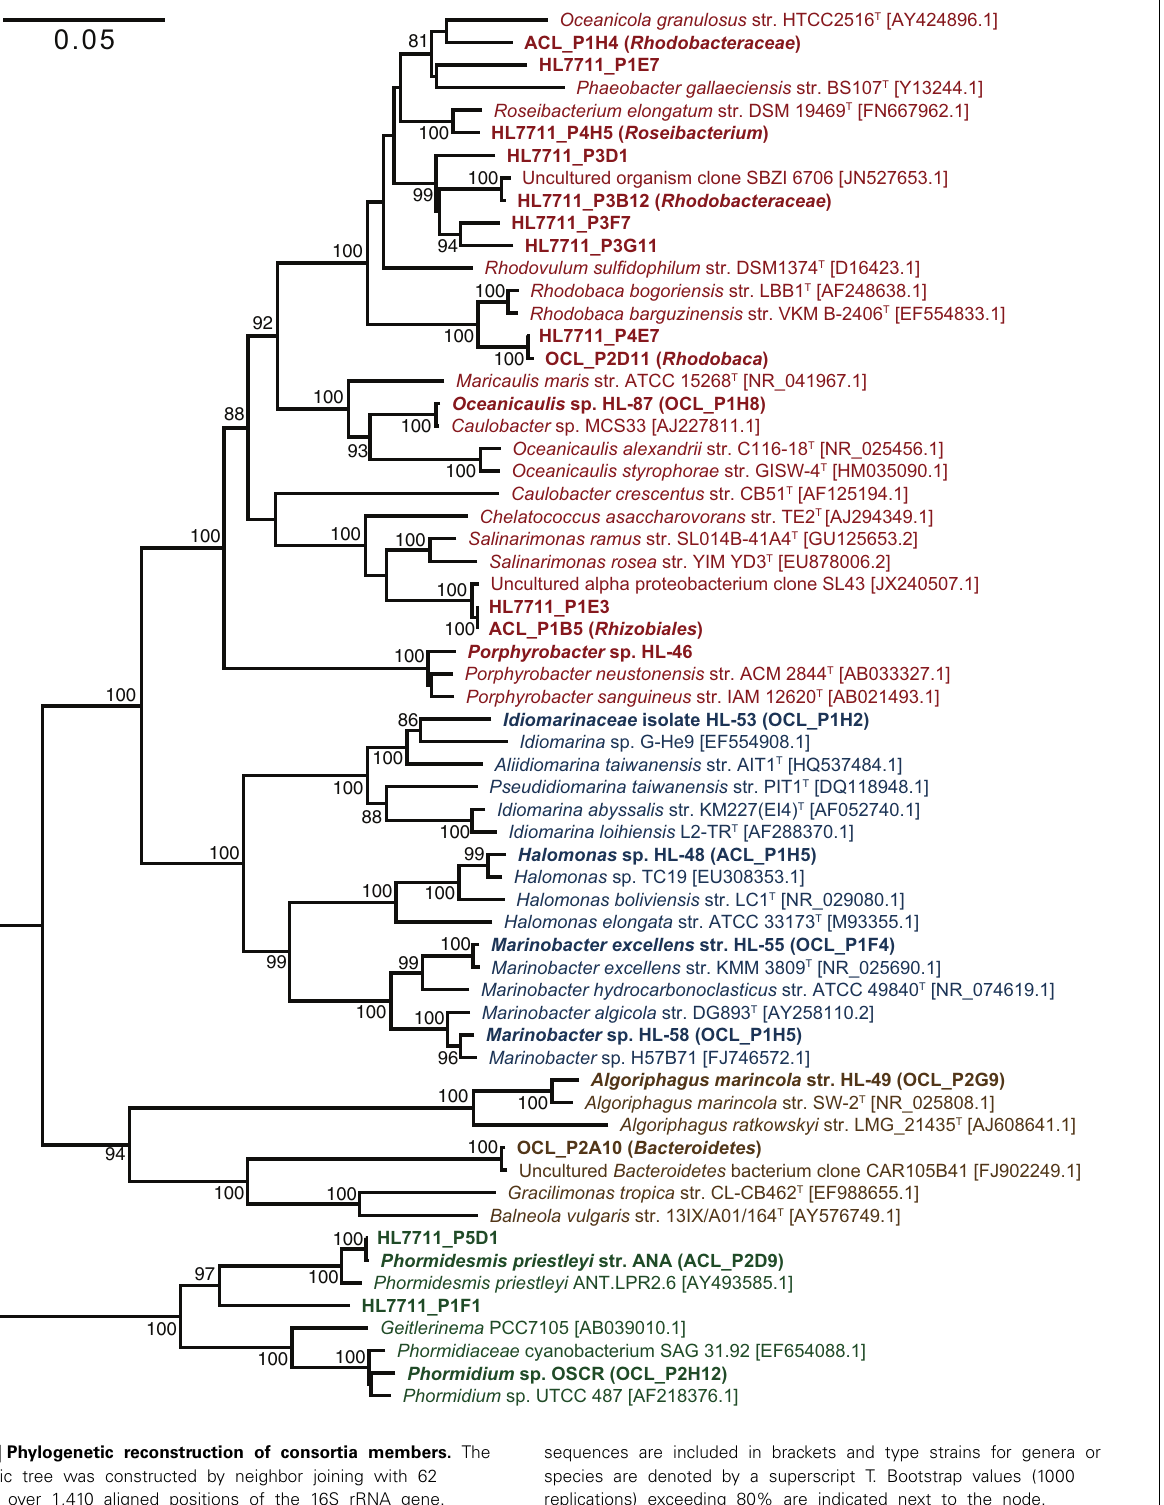
FIGURE 3 | Phylogenetic reconstruction of consortia members. The phylogenetic tree was constructed by neighbor joining with 62 sequences over 1,410 aligned positions of the 16S rRNA gene. Sequences representing consortia members were selected from clone libraries of UCC-A (ACL), UCC-O (OCL), and the whole mat (HL7711) (Lindemann et al., 2013) and are bolded. Isolates in pure culture are designated by strain number (HL-XX). GenBank numbers for reference